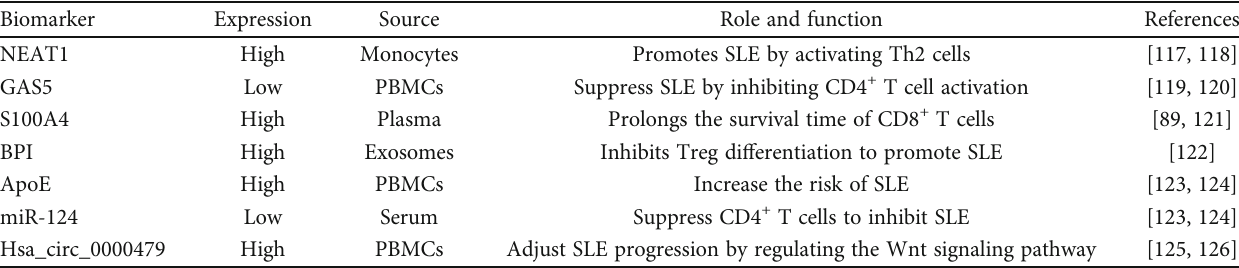
Table 1: Exosomal biomarkers in